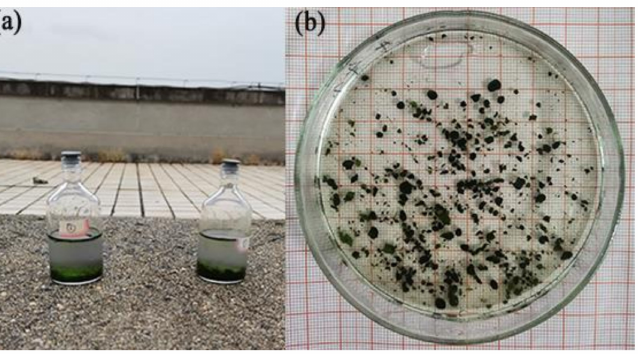
Figure 1. ( a ) A diagram of the experimental set-up and ( b ) the appearance of microalgal-bacterial granular sludge